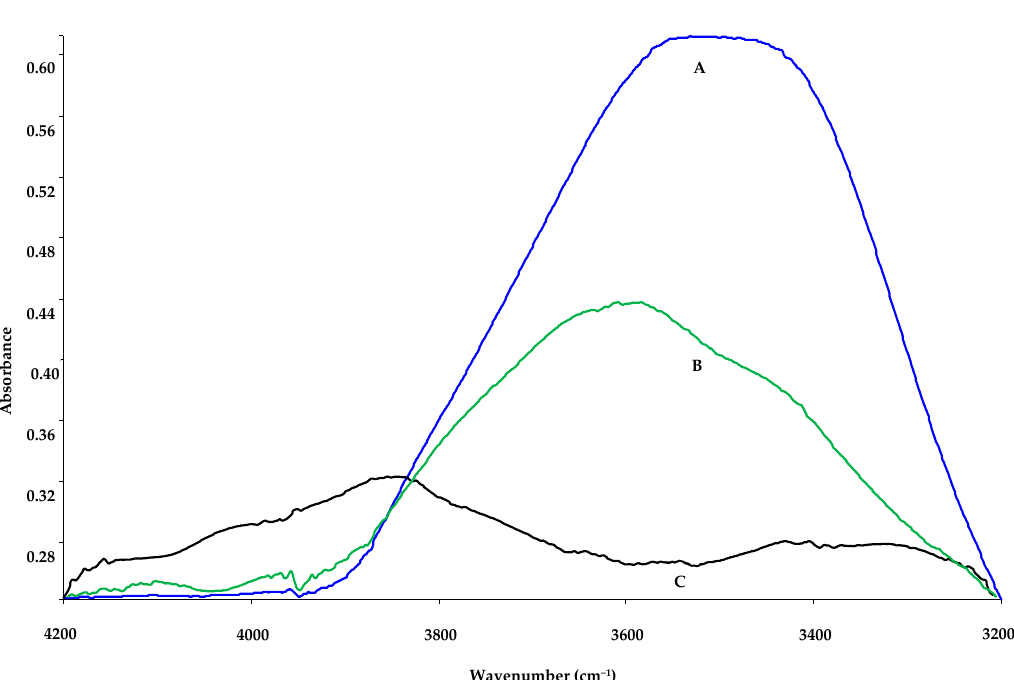
Figure 2. FT-IR spectra of the O–H region of Ga-BaY(Sil) calcined at ( A ) 250 °C, ( B ) 550 °C, ( C ) 750 °C.